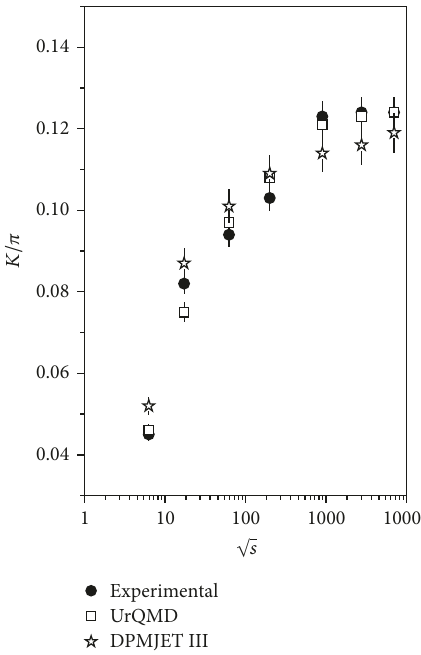
Figure 3: Variation of total kaon to pion multiplicity ratio ((𝐾 + + 𝐾 − )/(𝜋 + + 𝜋 − ) = 𝐾/𝜋) with energy √𝑠 in pp collisions at √𝑠 = 6.3 GeVto7 TeVfortheexperimentaldataextractedfromthepapers of different collaborators, UrQMD model simulated values, and DPMJET III model simulated